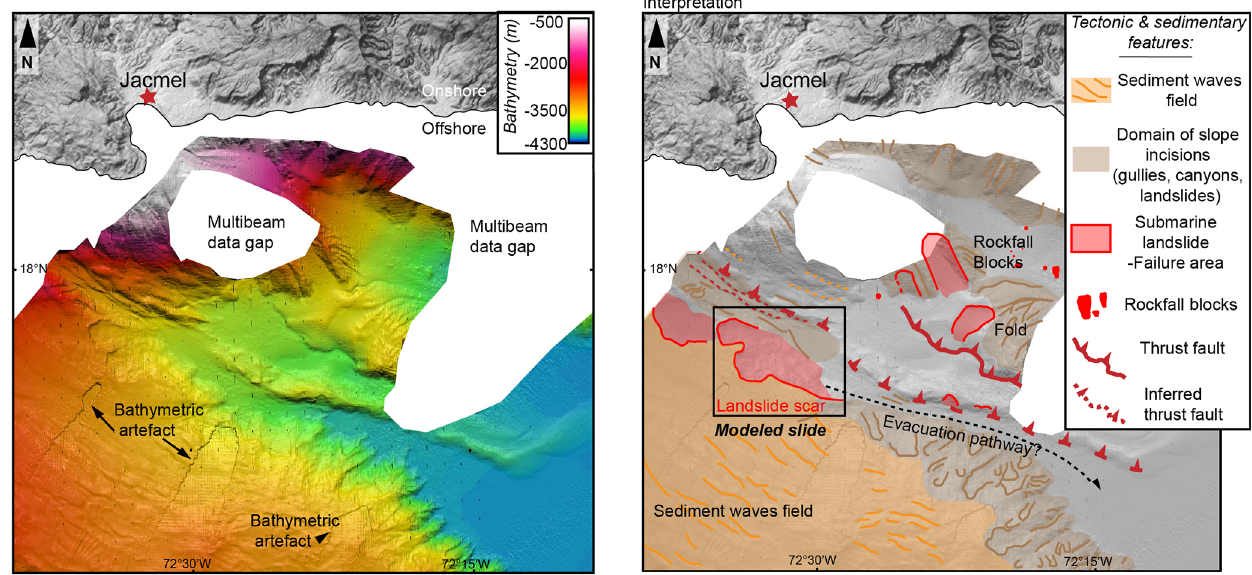
Figure 5. Detailed bathymetry 20km due south of Jacmel (Fig. 1) where the landslide scar discussed in the text has been identified. (a) Raw observations. (b) Geological interpretation. Swath bathymetric data are from Haiti-sis cruise (https://doi.org/10.17600/12010070, Leroy, 2012). The white area corresponds to missing bathymetry of the boat campaign (Leroy et al., 2015).